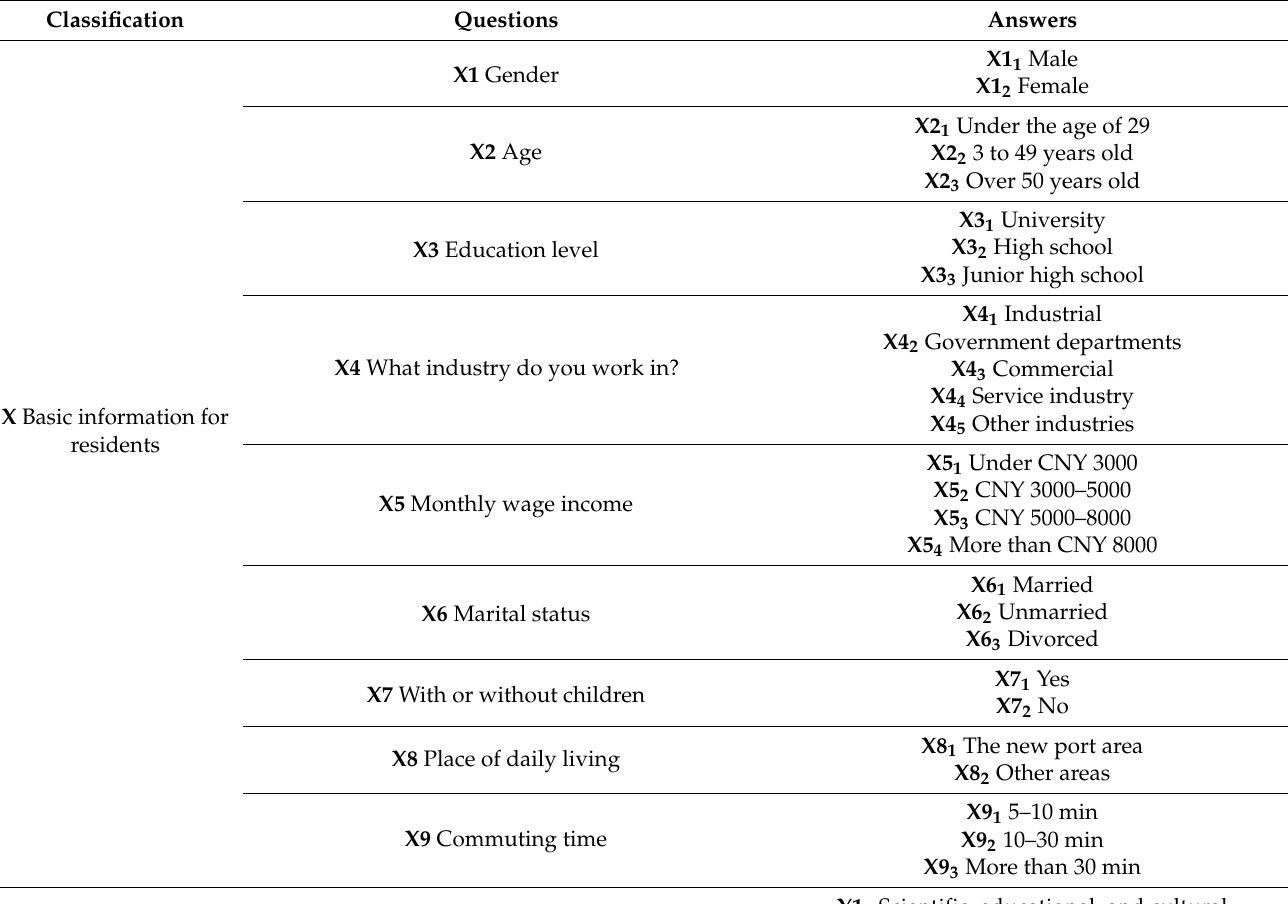
Table 3. Main contents of the